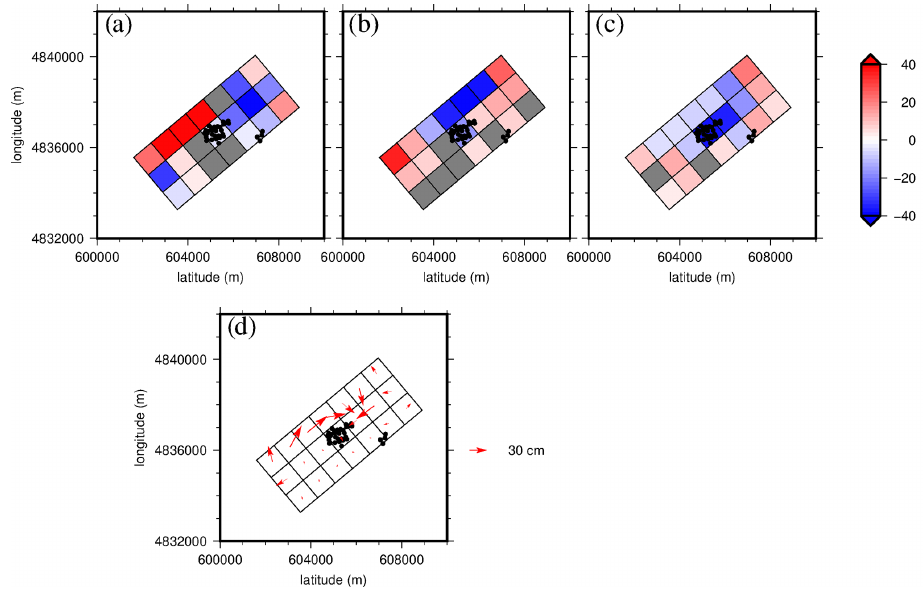
Figure 11. Distribution of the significant optimal dislocation parameters: (a) strike-slip, (b) dip-slip, (c) tensile, and (d) slip displacement (strike and dip) of the hanging wall relative to the foot wall. The black dots indicate the location of well heads. Non-significant dislocations are represented in gray.